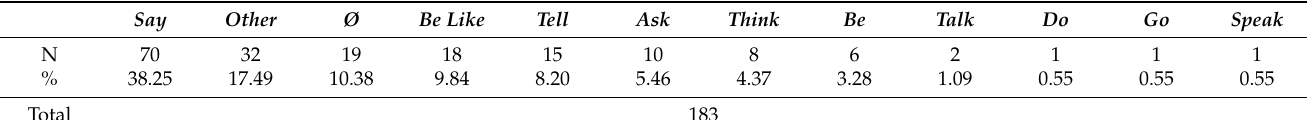
Table 4. General distribution of different forms in our